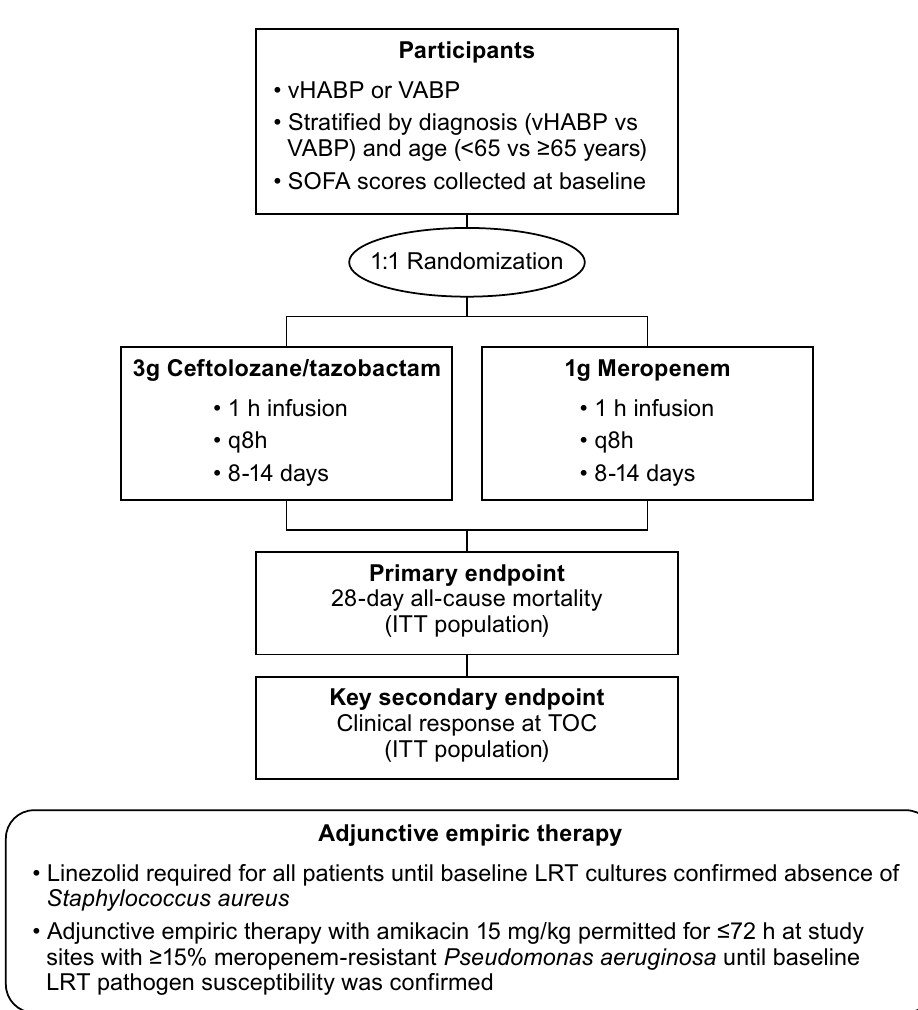
Fig. 1 ASPECT‑NP study design [20]. h hour, ITT intent‑to‑treat, LRT lower respiratory tract, q8h every 8 h, TOC test‑of‑cure, SOFA Sequential Organ Failure Assessment, VABP ventilator‑associated bacterial pneumonia, vHABP ventilated hospital‑acquired bacterial